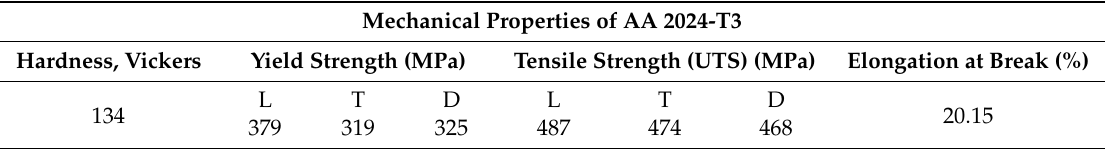
Table 1. Mechanical properties of the aluminium alloy AA2024-T3.